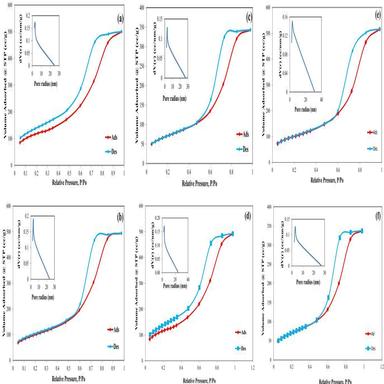
N2 adsorption–desorption isotherms of the a) Si0, b) Si5, c) Si7,d) Si8,e) Si9 and f) Si10 sample including PSDs (inset).